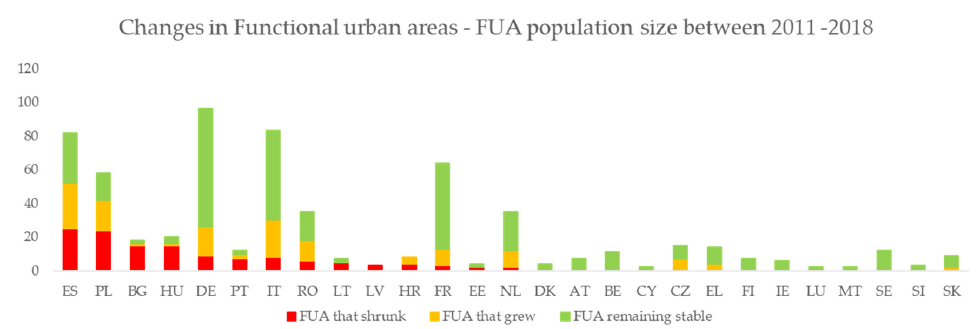
Figure 2. Changes in Functional Urban Areas-FUA population size between 2011 and 2018. (Authors’ elaboration based on Joint Research Centre data [50]).